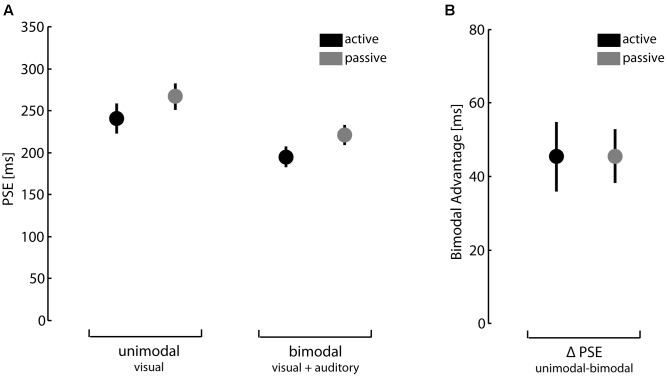
Perception of action consequences. (A) Points of subjective equality (PSE) for unimodal and bimodal feedback under active and passive action conditions. (B) Difference between PSEs for unimodal and bimodal feedback under active and passive action conditions. Error bars depict standard errors of mean.